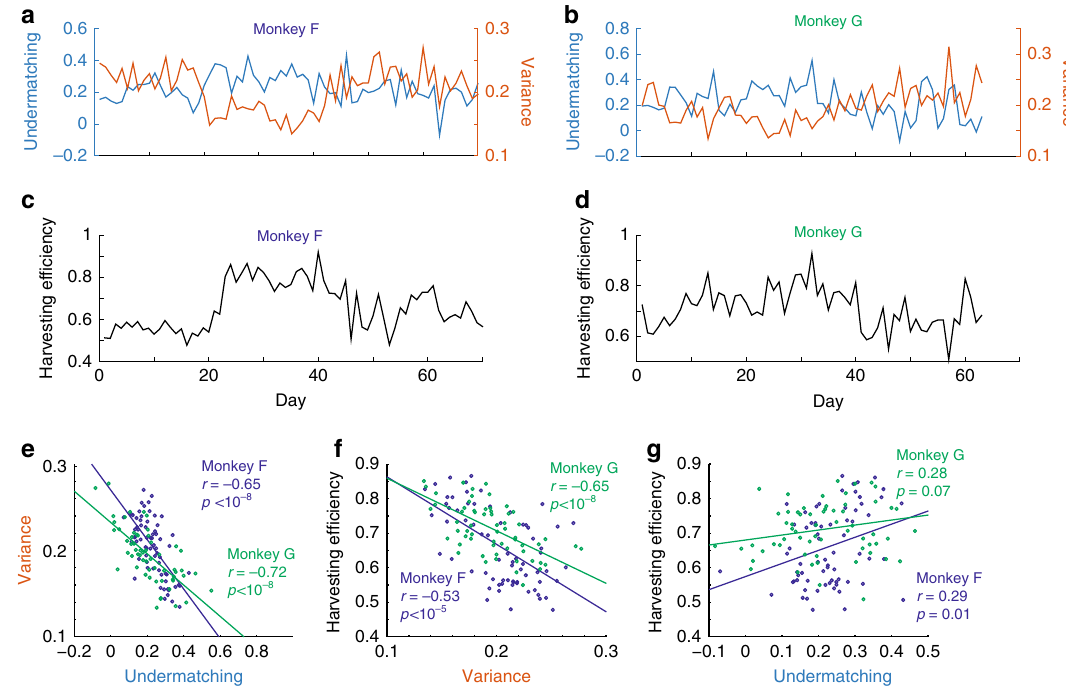
Fig. 4 Monkeys show the predicted tradeoff (model-independent analysis). a – d Changes in undermatching, variance of choice and harvesting ef fi ciency over experimental days. e – g Monkeys show the bias-variance tradeoff. e Undermatching (1 − the slope of matching behavior) and the variance of choice are signi fi cantly correlated negatively [permutation test: p < 10 − 8 for Monkey F and p < 10 − 8 for Monkey G]. This means that the monkeys trade off the bias (undermatching) against the variance of estimation, as predicted by our model. f By reducing variance of choice, monkeys improved their harvesting performance. The harvesting ef fi ciency is signi fi cantly negatively correlated with the variance of choice [permutation test: p < 10 − 8 for Monkey F and p < 10 − 5 for Monkey G]. g Although increasing bias is harmful, bene fi ts from reducing the variance of choice outweigh the costs [permutation test: p < 0.07 for Monkey F and p < 0.01 for Monkey G]. Note that in these fi gures squared root of variance is shown as